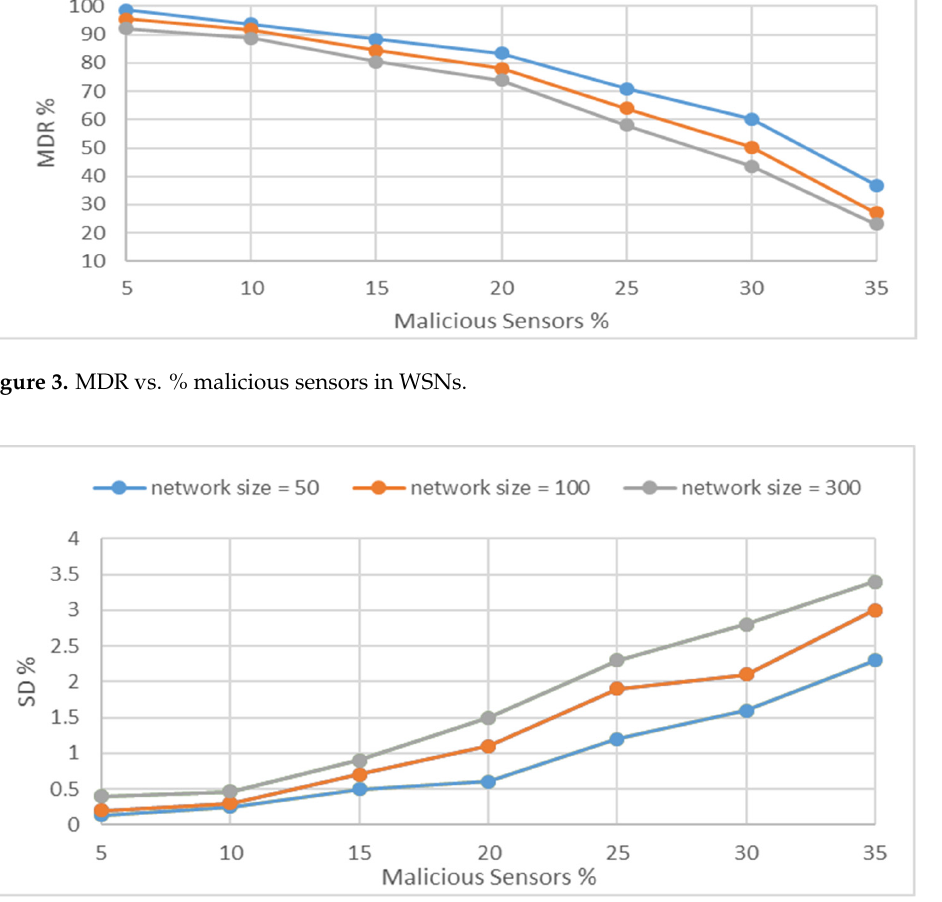
Figure 3. MDR vs. % malicious sensors in WSNs.